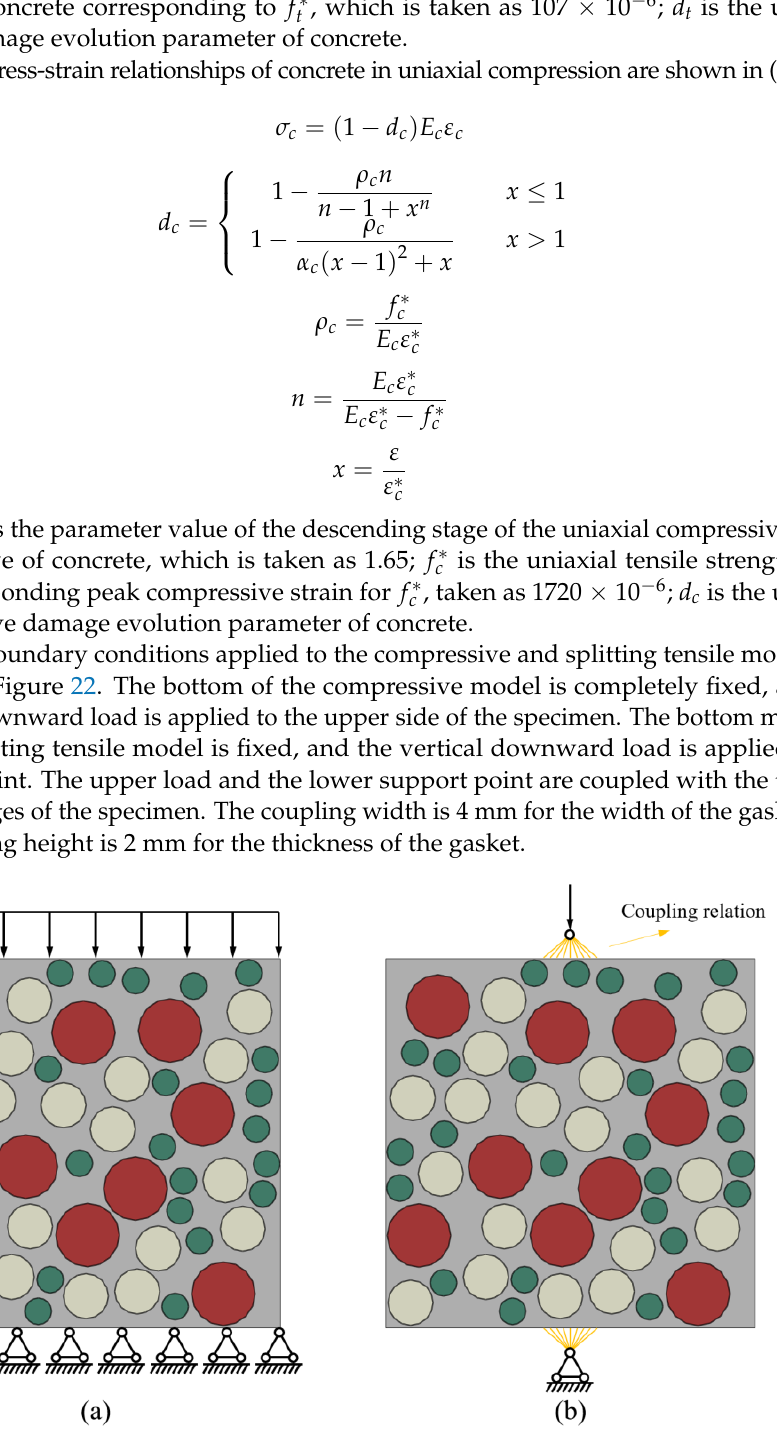
Figure 22. Load application method for compressive and splitting tensile specimens. ( a ) Compressive and ( b ) splitting tensile.